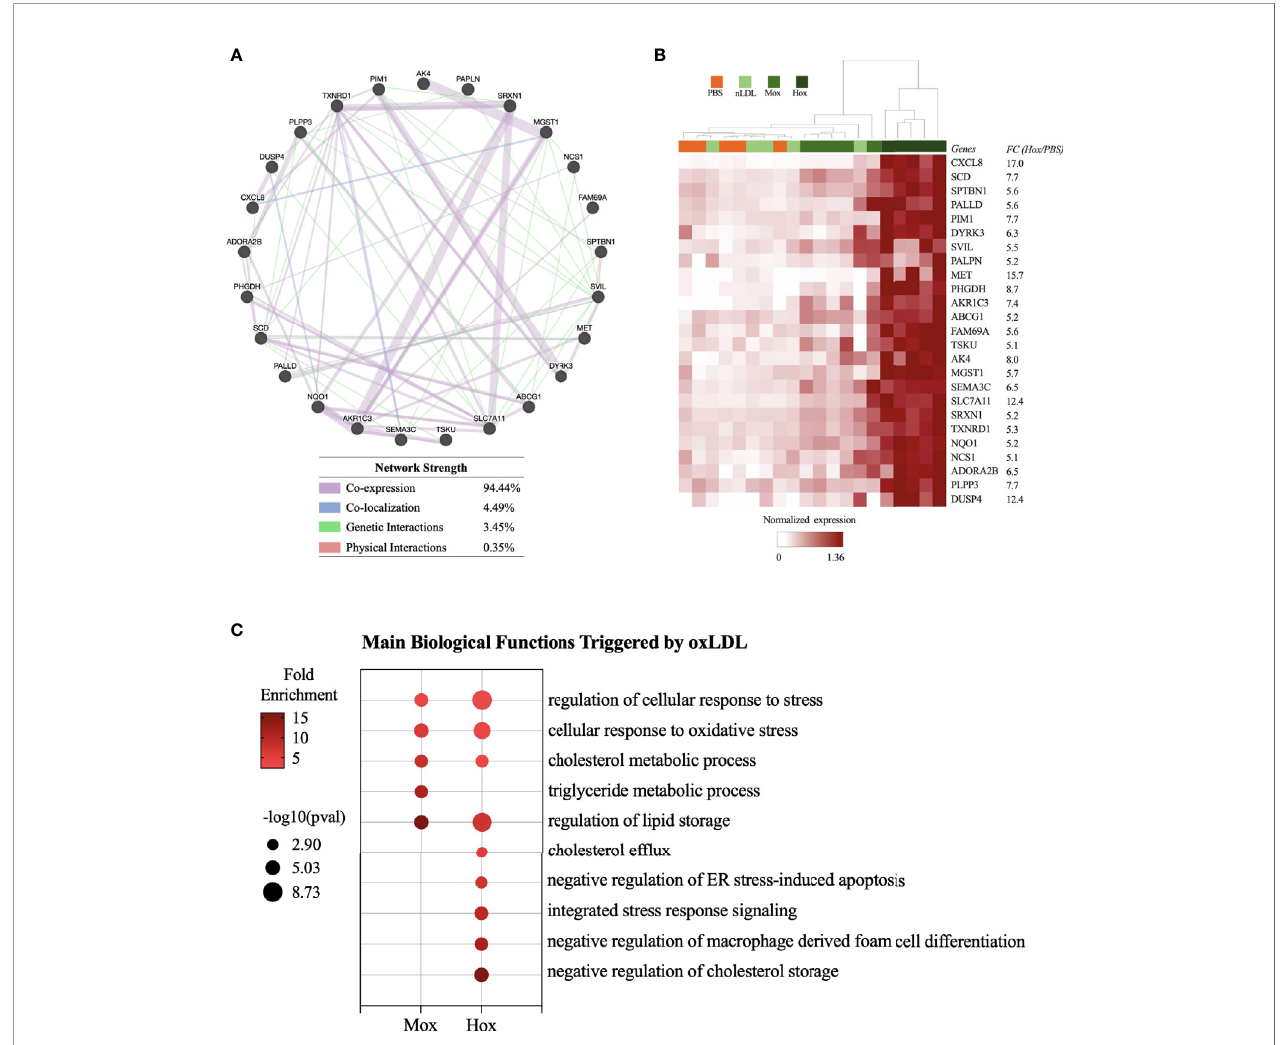
FIGURE 2 | Transcriptome-based signature and biological processes triggered by HoxLDL stimulation. (A) Using the top 40 genes upregulated HoxLDL biomarker list, we performed a network test using GeneMANIA, which identi fi ed a strong relationship among the 25 genes. (B) In the heatmap, we can see that the hierarchical clustering of the 25 genes (HoxLDL group), group all the HoxLDL-stimulated samples together (n=5) . (C) Biological processes upregulated in M2-like cells exposed to MoxLDL and HoxLDL for 24